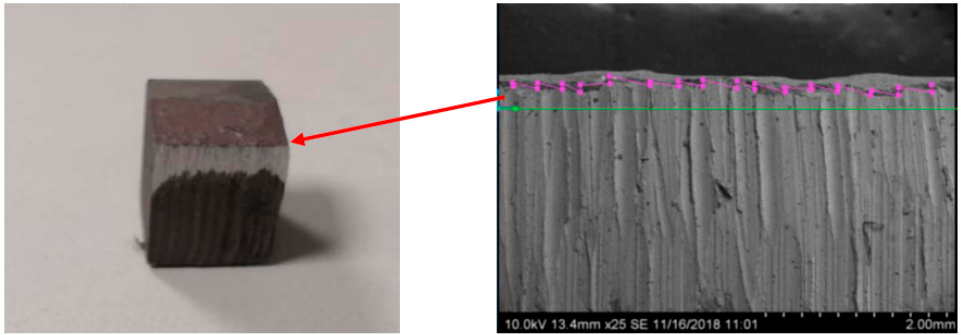
Figure 7. Illustration of the SEM measurement of the primer thickness.